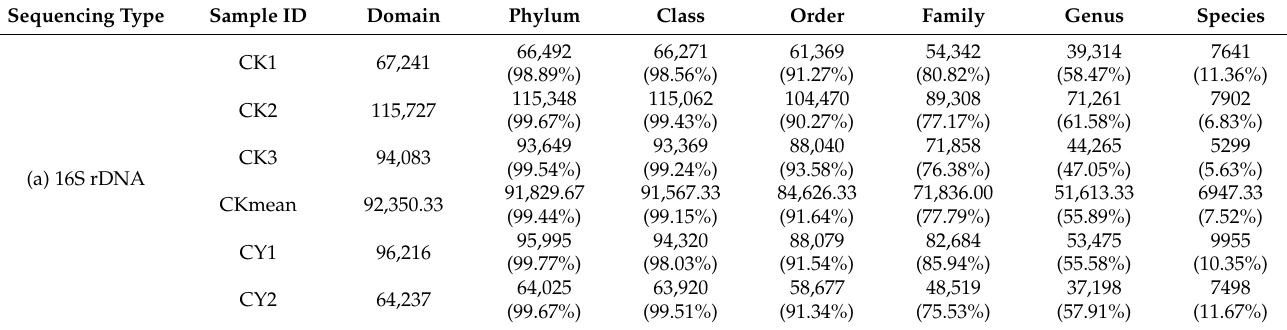
Table 2. The distribution of annotated tags in different taxonomic